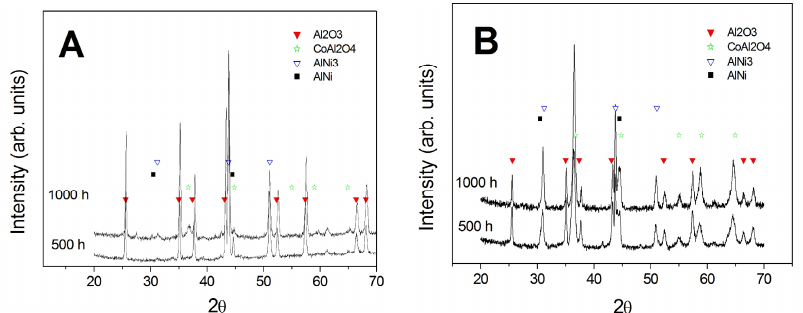
Figure 14. Surface XRD pattern of IN738 + CoNiCrAlY + Pack aluminizing + Post treatment ( A ) and IN738 + CoNiCrAlY + IL aluminizing + post treatment ( B ), respectively, after 500 and 1000 h of isothermal test (1000 °C).